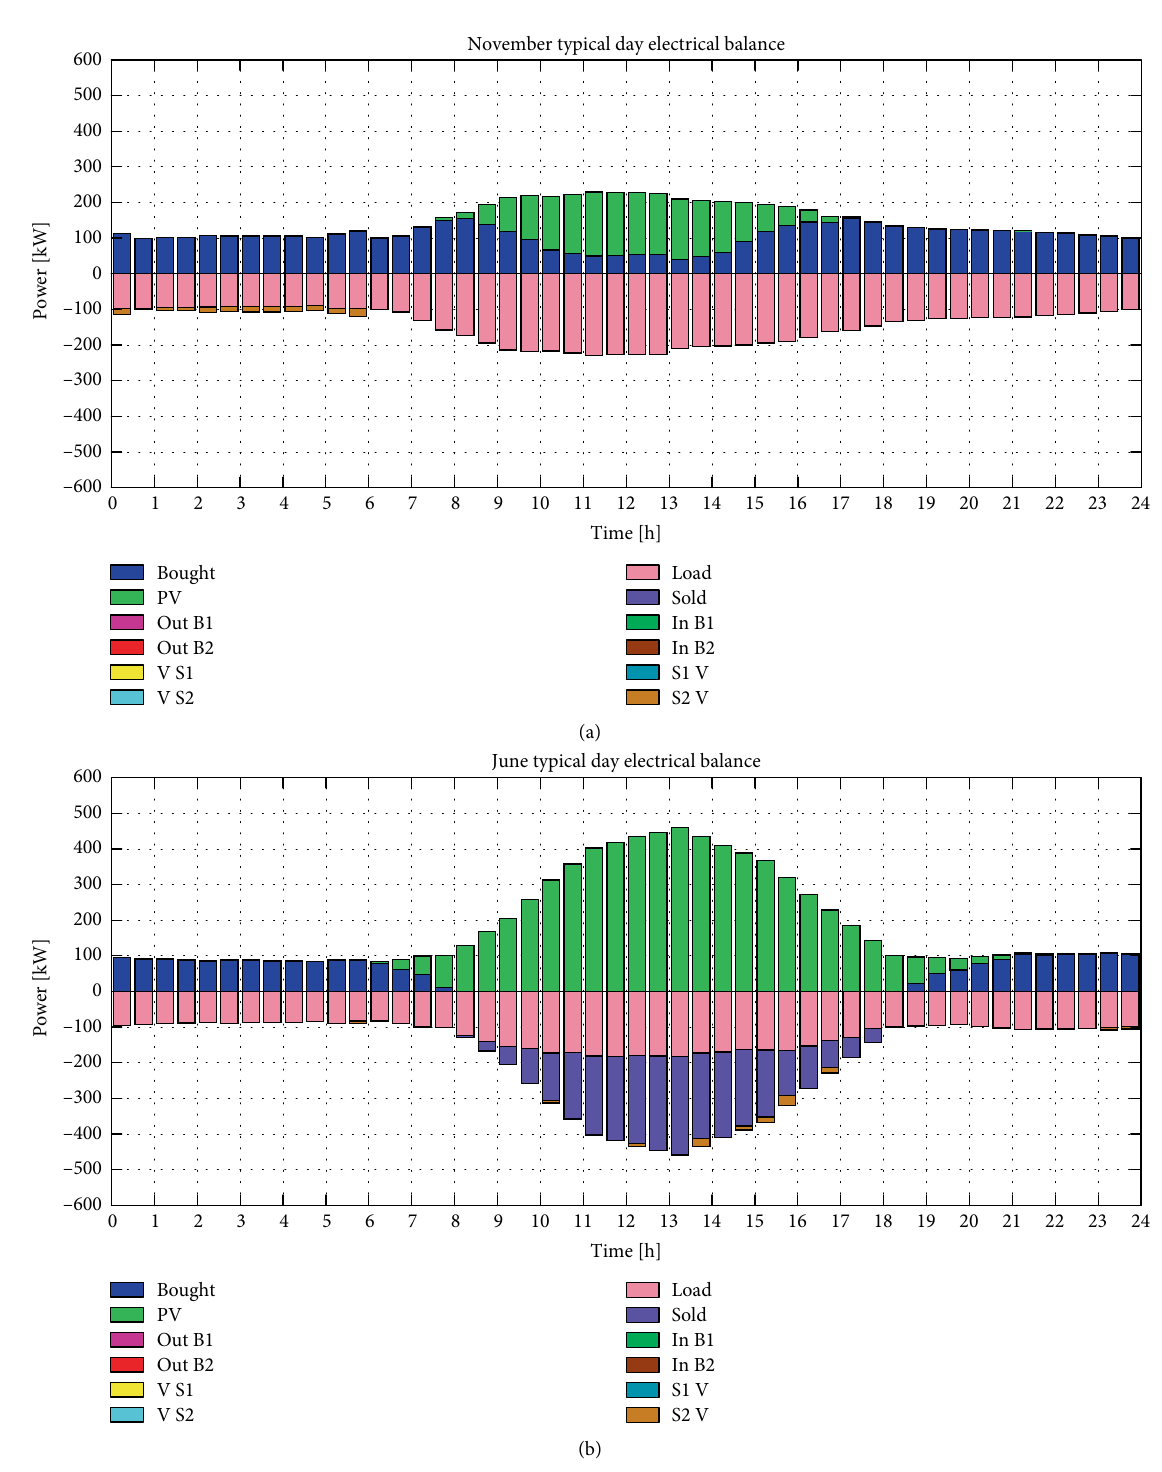
Figure 3: (a) November day electrical balance for Case 4. (b) June day electrical balance for Case